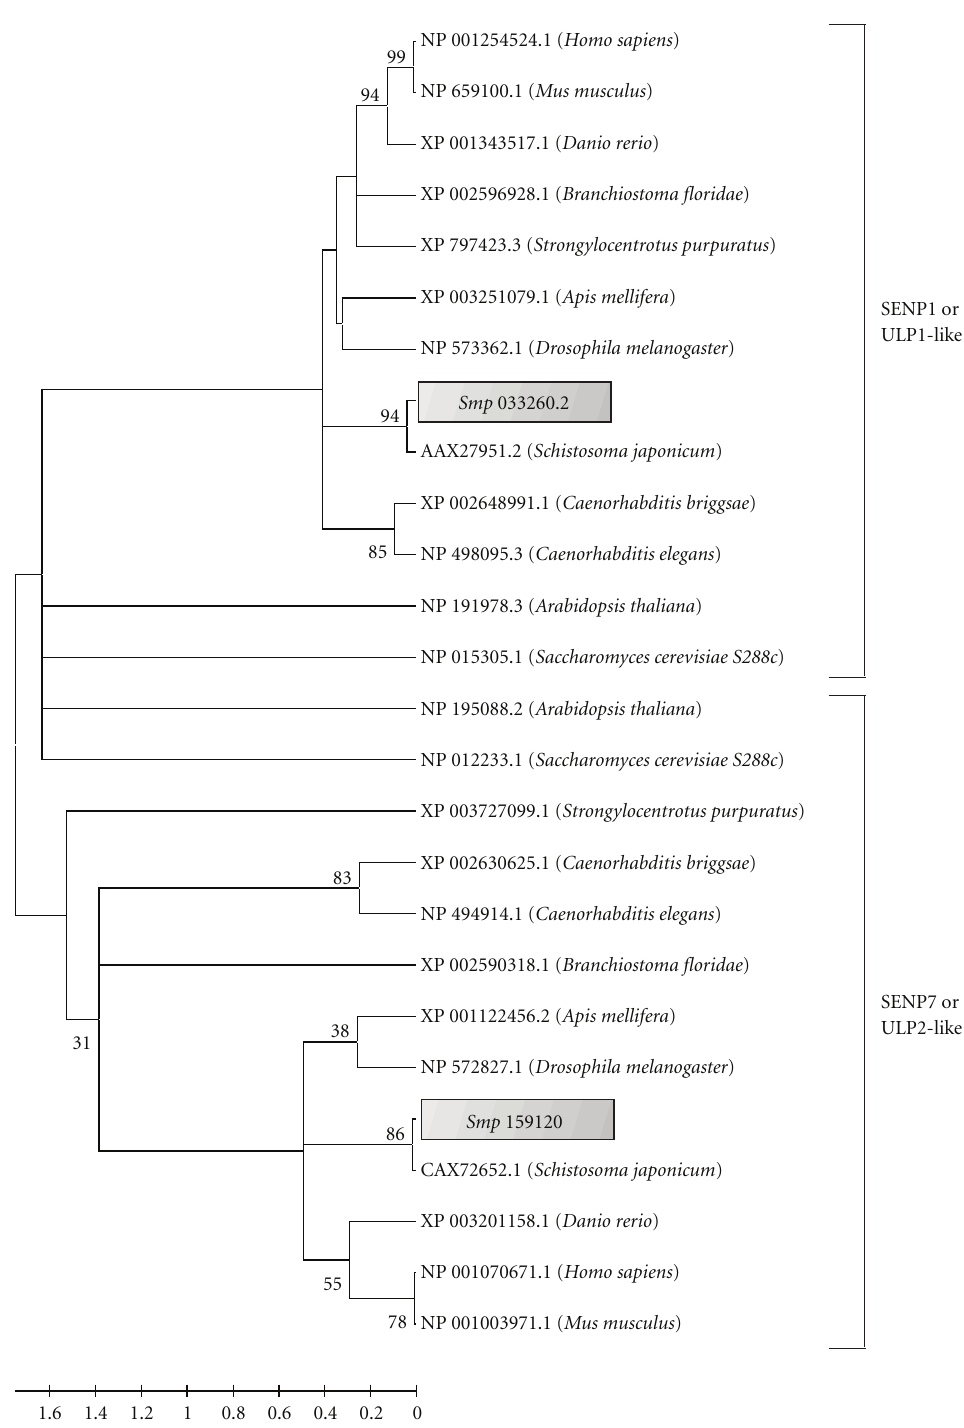
Figure 1: Consensus phylogenetic tree based on amino acid sequences of Sm SENPs. The tree construction and analysis of bootstrap were performed using ClustalX 2.0 and MEGA 4.0. For the consensus tree and reliability of the branches formed test was used phylogenetic bootstrap using 1000 replicates for each sequence, and 50% the minimum for considering the branch reliably. Organisms: Hs ( Homo sapiens ), Mm ( Mus musculus ), Rn ( Rattus norvegicus ), Xl ( Xenopus laevis ), Sm ( Schistosoma mansoni ), Sj ( Schistosoma japonicum ), Dm ( Drosophila melanogaster ), Cb ( Caenorhabditis briggsae ) and Ce ( Caenorhabditis elegans